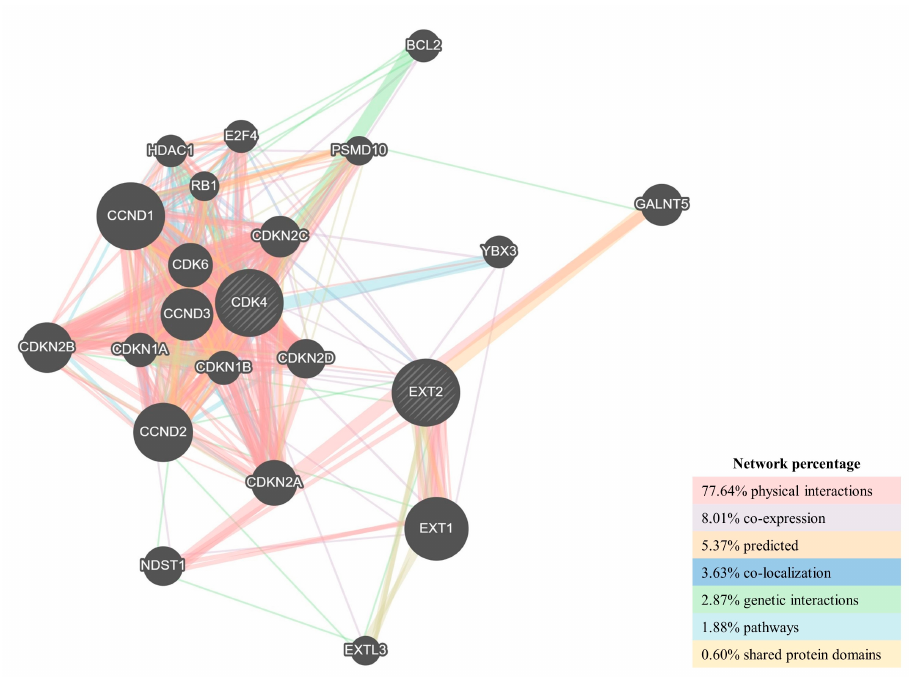
Figure 8. Protein–protein interaction (PPI) network for CDK4 and EXT2 was constructed in GeneMANIA. Different colours of the network edge indicate the bioinformatics methods applied: physical interaction, co-expression, predicted, co-localization, pathway, genetic interaction, and shared protein domains.